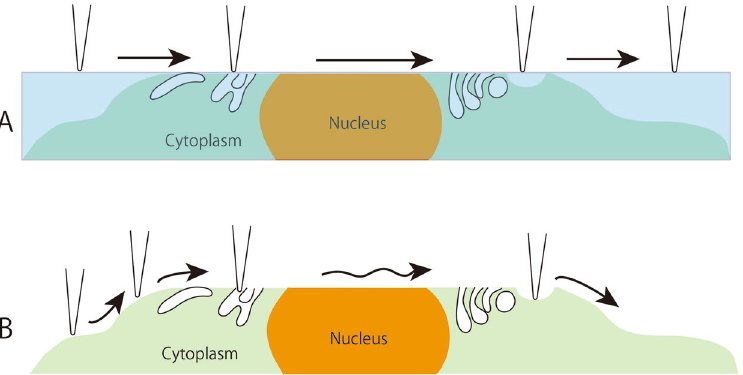
Figure 1. An illustration showing the difference in imaging between resin sections ( A ) and cryosections ( B ) with AFM. A: Polymerized resin is hard to remove; therefore, the cantilever just traces the flat surface of the resin section. B: For the cryosection, the embedding medium (sucrose) was removed by immersing the sections in PBS. The fine structures in cells and tissues were then exposed, which enabled the cantilever to trace along any undulations that